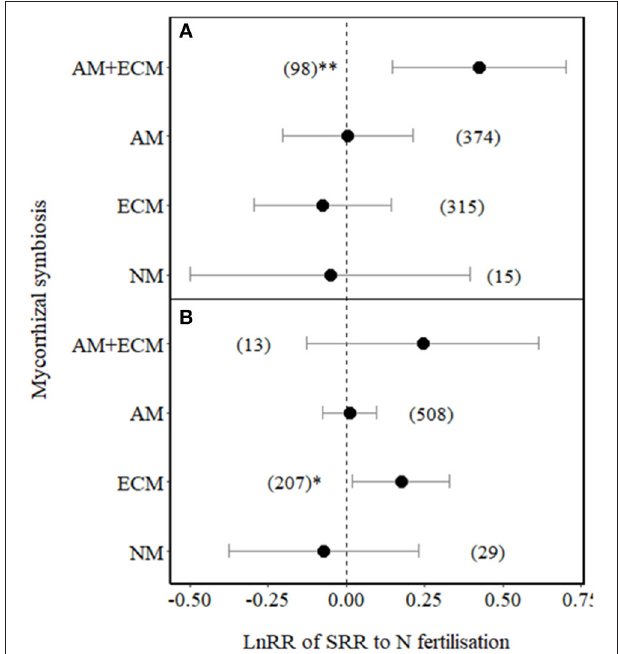
FIGURE 3 | Effect sizes (LnRR) of SRR in plants with no mycorrhizal associations (NM), with ECM associations only, AM associations only, or AM + ECM associations, for (A) low N fertilisation levels ( N ≤ 100kg ha − 1 ) and (B) high N fertilisation levels ( N > 100kg ha − 1 ). Numbers in brackets represent the number of observations and error bars represent the 95% CIs. ** and * indicate significance at p < 0.01 and p < 0.05, respectively. Only observations from field experiments are